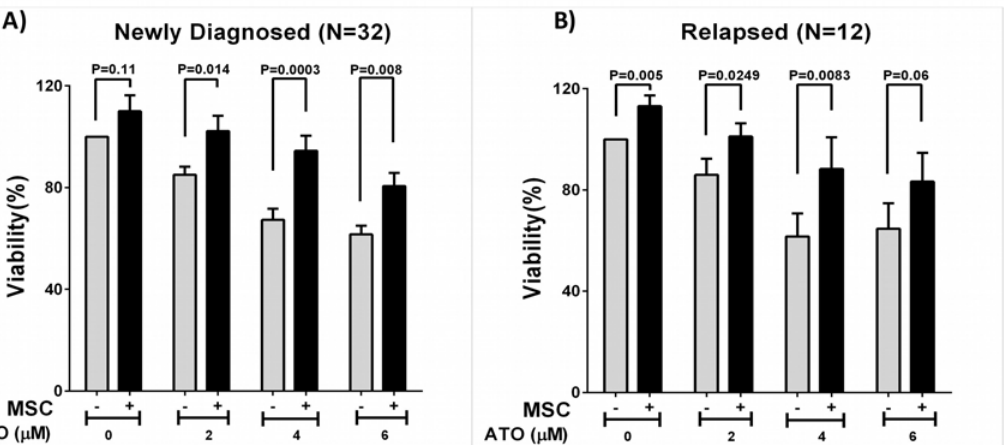
Fig 5. Impact of in vitro environment mediated (stromal cell co-culture) interaction on effect of ATO sensitivity at diagnosis and in relapsed cases. The bar graph shows the mean viability percentage of the newly diagnosed [A] and relapsed [B] patients primary cells when cultured with or without stromal cells (MSCs) and at varying concentrations of ATO incubated for 48 hours prior to apoptosis assay. There is a significant protective effect on primary cells in both groups by MSC co-culture to ATO induced